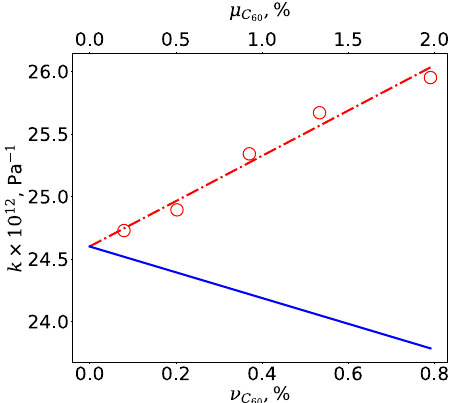
Figure 3. Dependence of compressibility on the concentration of fullerenes in the aluminum melt (the solid line, calculation by the ROM; the symbols, the MD data; and the dash-dotted line, the least-squares approximation of the calculated